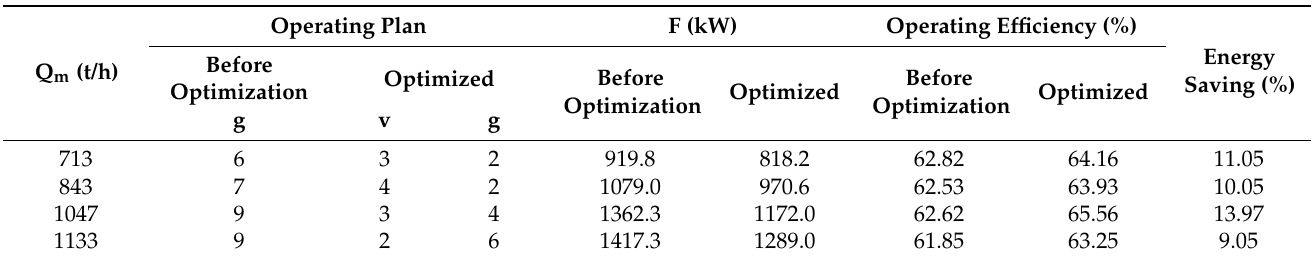
Table 4. Comparison of optimized operation power consumption of LNG submerged pump